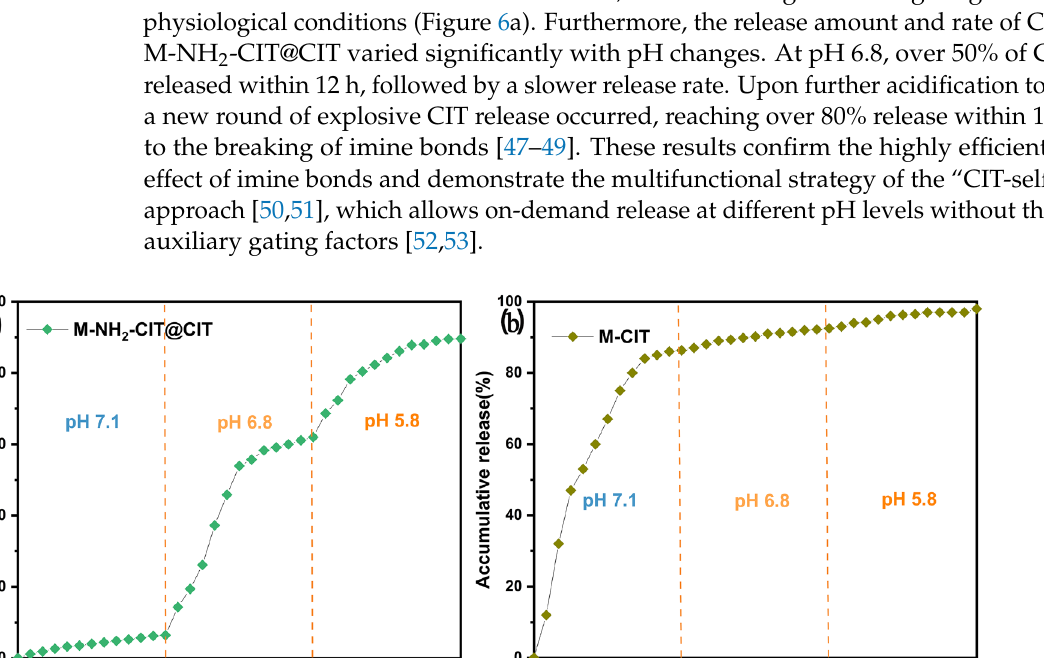
Figure 6 . CIT release curves of M-NH2-CIT@CIT ( a ) and M-CIT ( b ) at different pH val- ues in vitro.